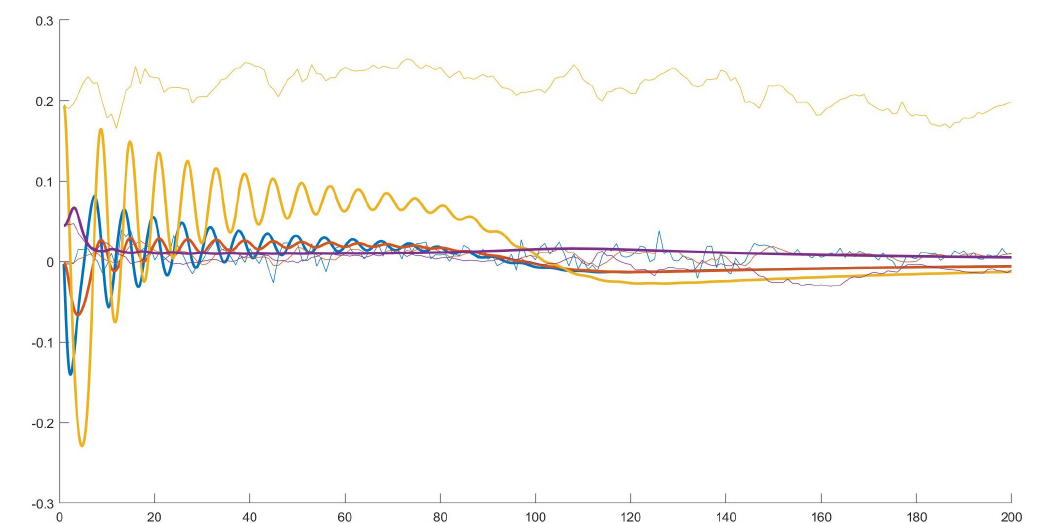
Figure 7. Time series obtained with parameters of calibration 3, that displays lightly damped oscillatory behaviour around the long-run equilibrium. Legend: blue = rate of growth, red = expected rate of growth, yellow = share of saved income, violet: trade to income ratio. Thick line: model, normal line: